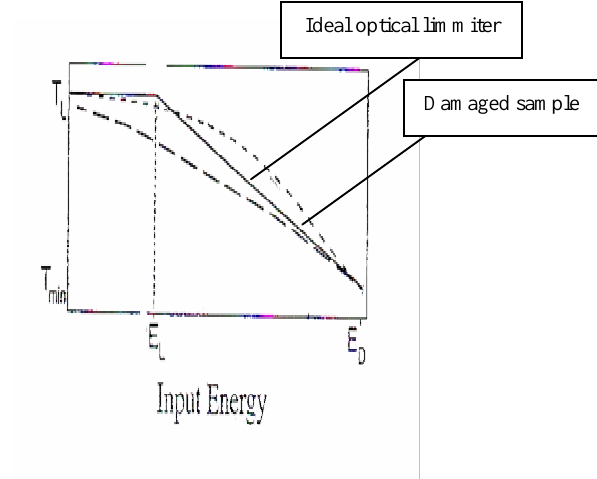
Fig.2: Transmittance output of an ideal optical limiter as a function of the input fluence or energy[7]